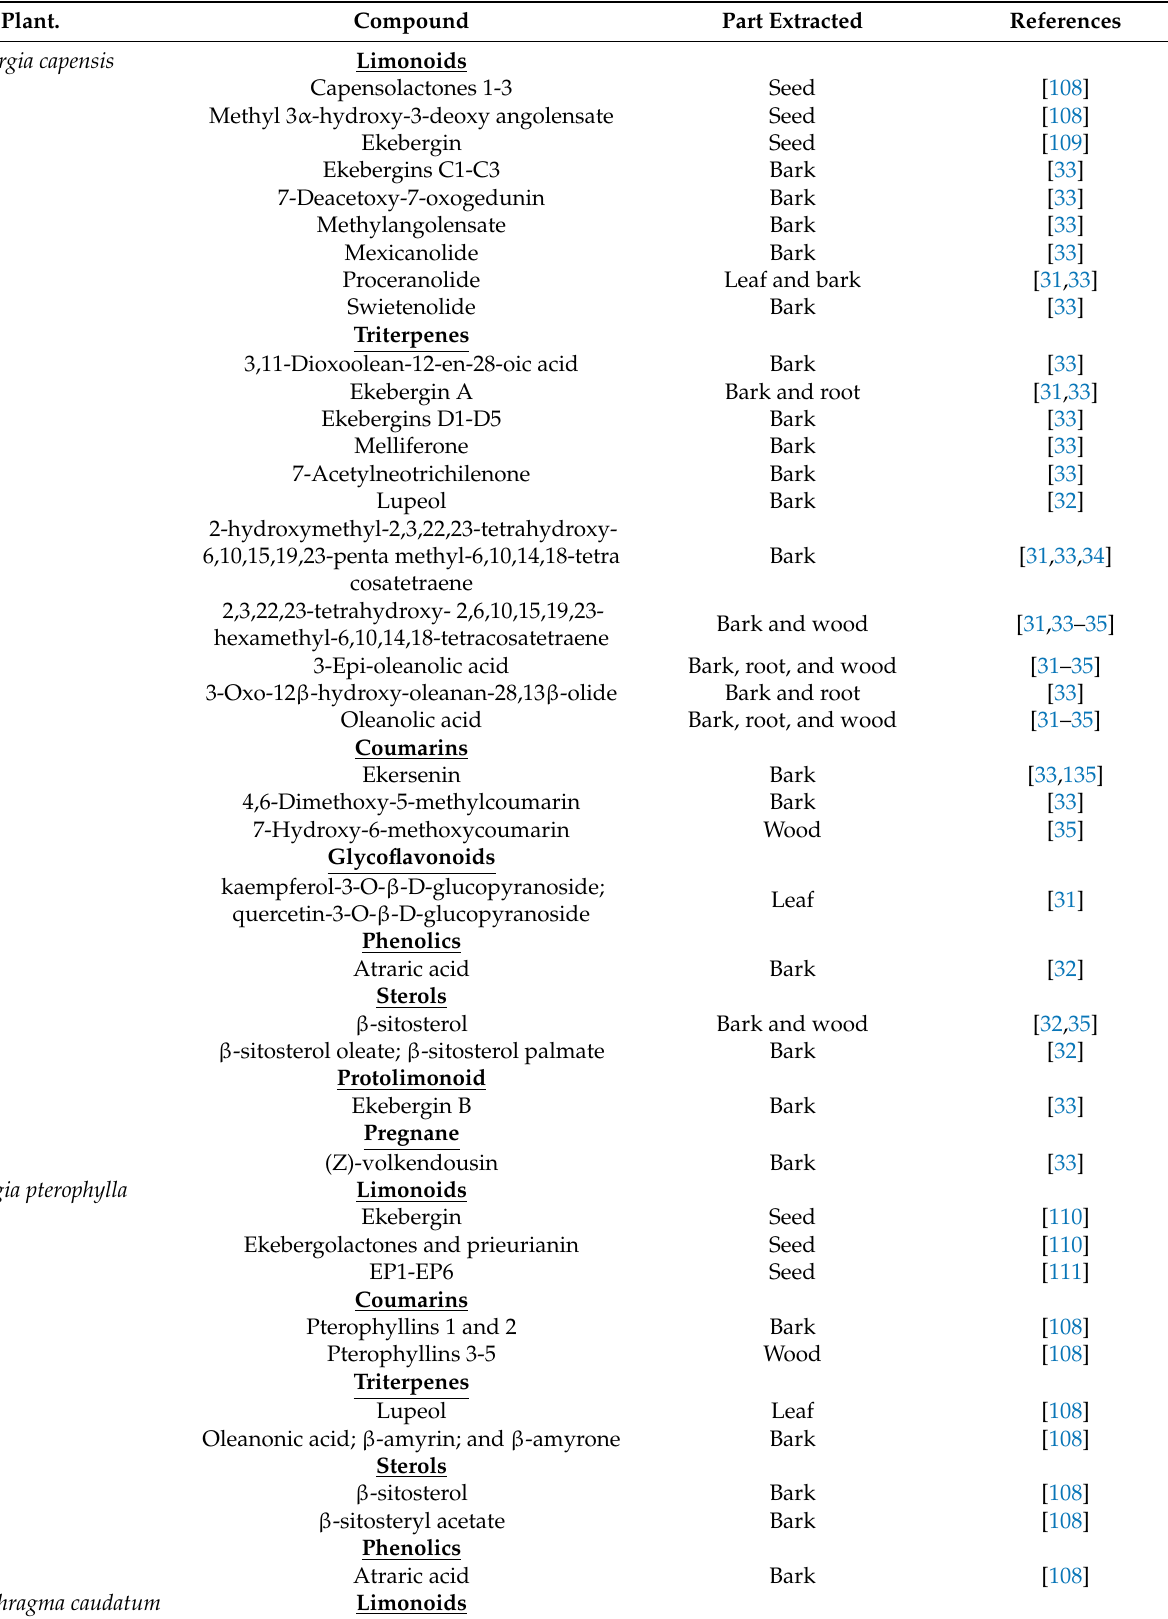
Table 3. Isolated compounds extracted from various parts of South African Meliaceae.